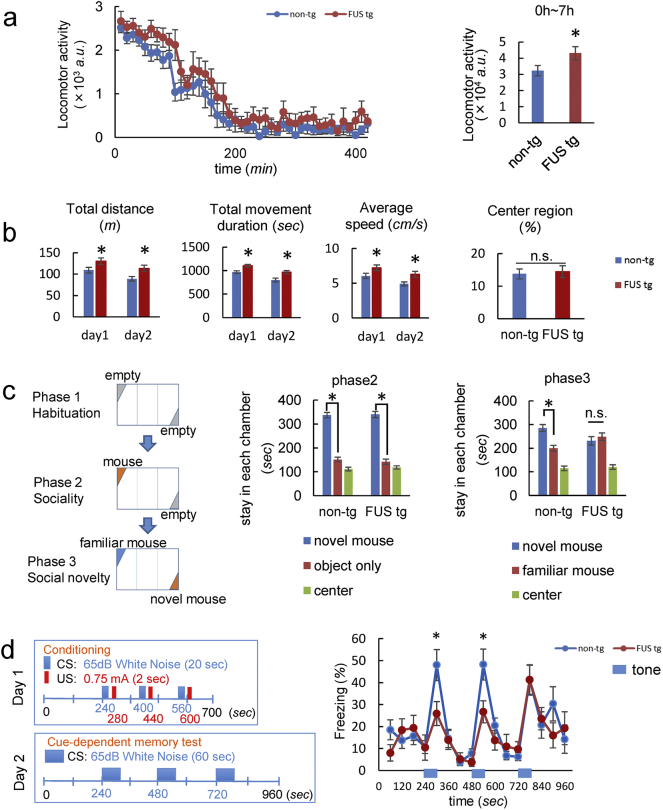
Mutant FUS transgenic mice showed behavioral and cognitive impairment.Fourteen mutant FUS and fifteen non-tg mice were evaluated on all batteries. (a) Home cage locomotor activity during the adaptation period. (b) The total distance moved, total movement duration, average speed, and time spent in the center region in the open-field test. Transgenic mice exhibited hyperactivity in their home cages and the open-field test. (c) Three-chamber test to assess sociability. The paradigm is briefly illustrated. Graphs show the time spent by the test mouse in the chambers with and without a novel mouse (phase two: left panel), or the novel mouse and familiar mouse chambers (phase three: right panel). (d) Trace fear conditioning test to evaluate long-term memory function. The temporal relationships of conditioned stimulus (CS) and unconditioned stimulus (US) are schematically shown. Blue and red numbers represent the onsets of CS and US. Twenty-four hours after conditioning, freezing ratios were assessed along with the auditory cues. Asterisks (*) indicate significant differences vs. non-tg mice (P < 0.05 by Student's t-test). n.s., not significant. a.u., arbitrary units. All error bars represent standard deviation of the mean.